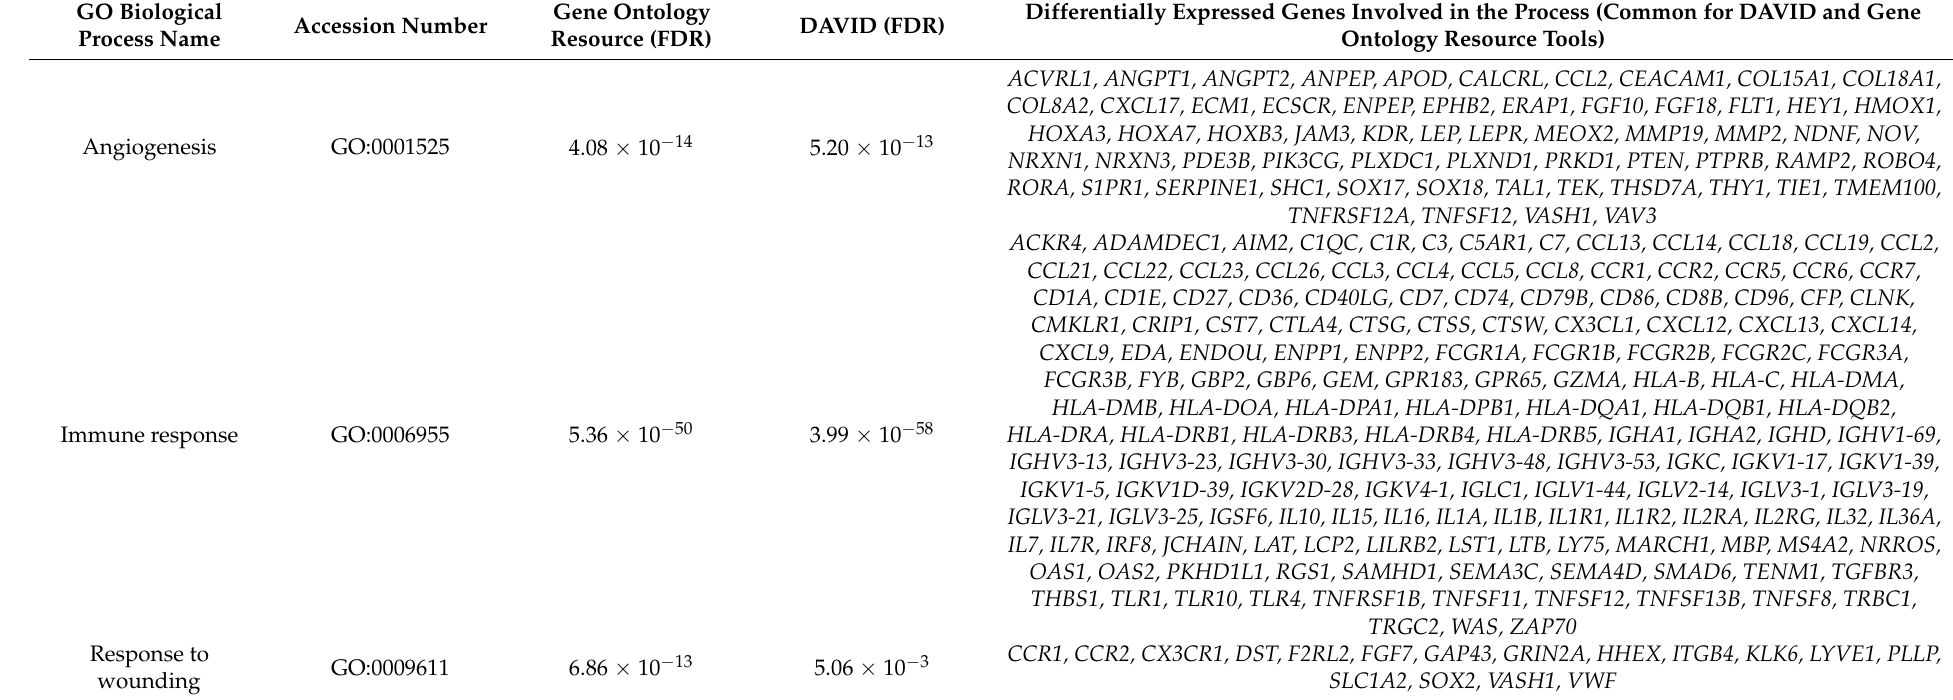
Table 1. Gene ontologies enriched in the group of surgical margins compared to the HBEpiC, HTEpiC, LAUP samples and the involved differentially expressed genes (returned by both tools DAVID and Gene Ontology